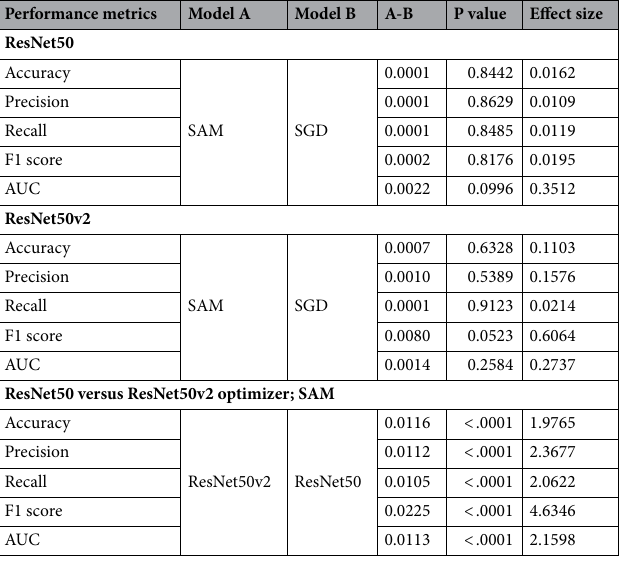
Table 4. Statistical evaluation of ResNet50 and ResNet50v2 with the SAM and SGD optimizers in continuity analysis. AUC, area under the receiver operating characteristic curve.